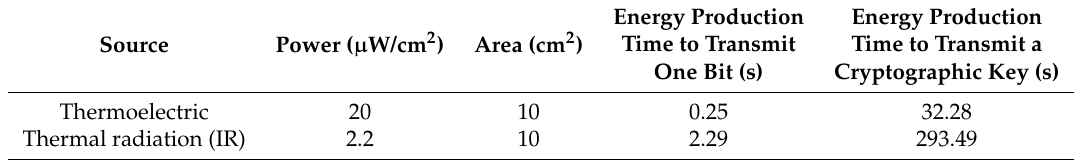
Table 5. Energy sources and time required for energy